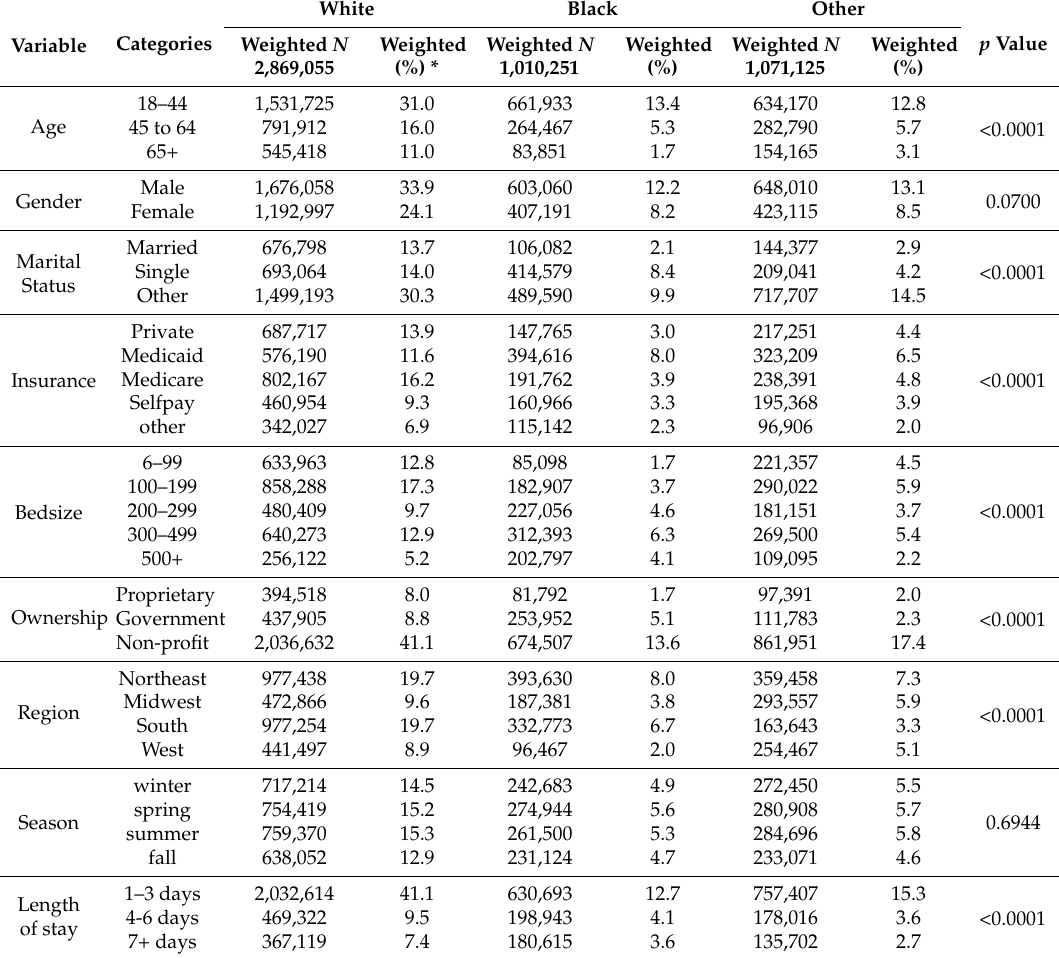
Table 2. Characteristics of hospital stays for AMA by racial